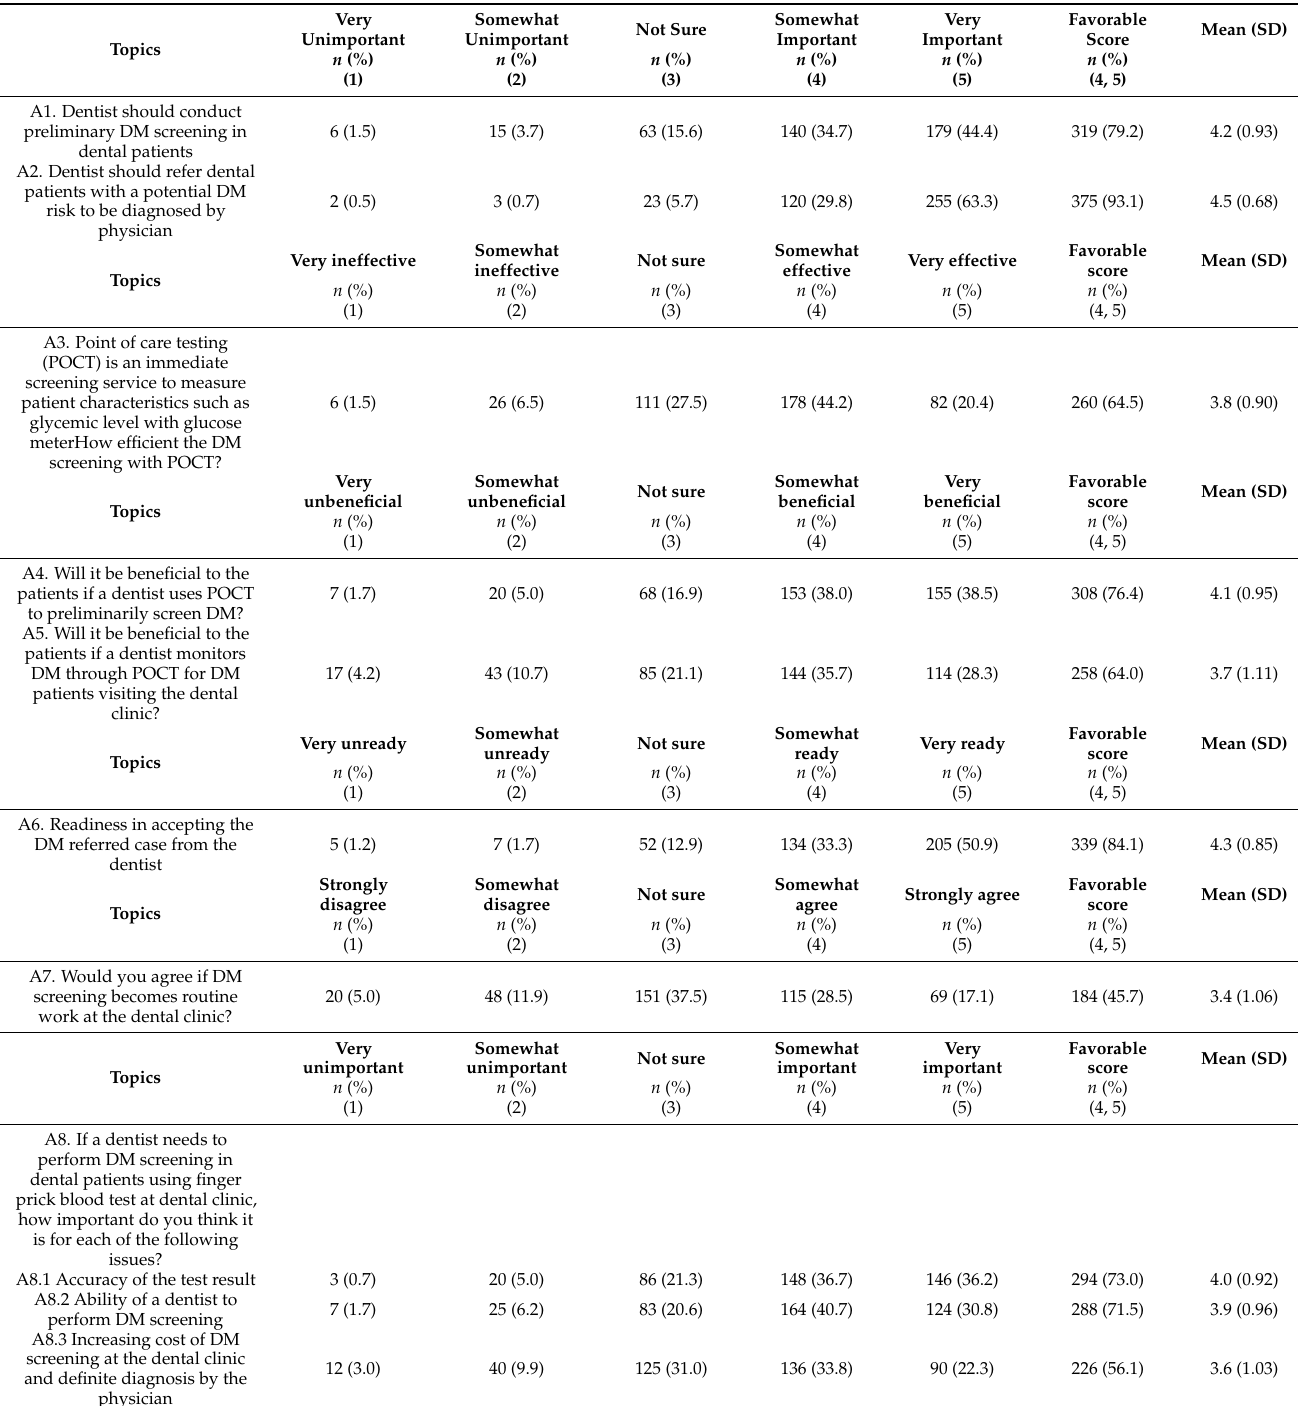
Table 3. Attitude of medical doctors towards diabetes screening in the dental clinic ( n =